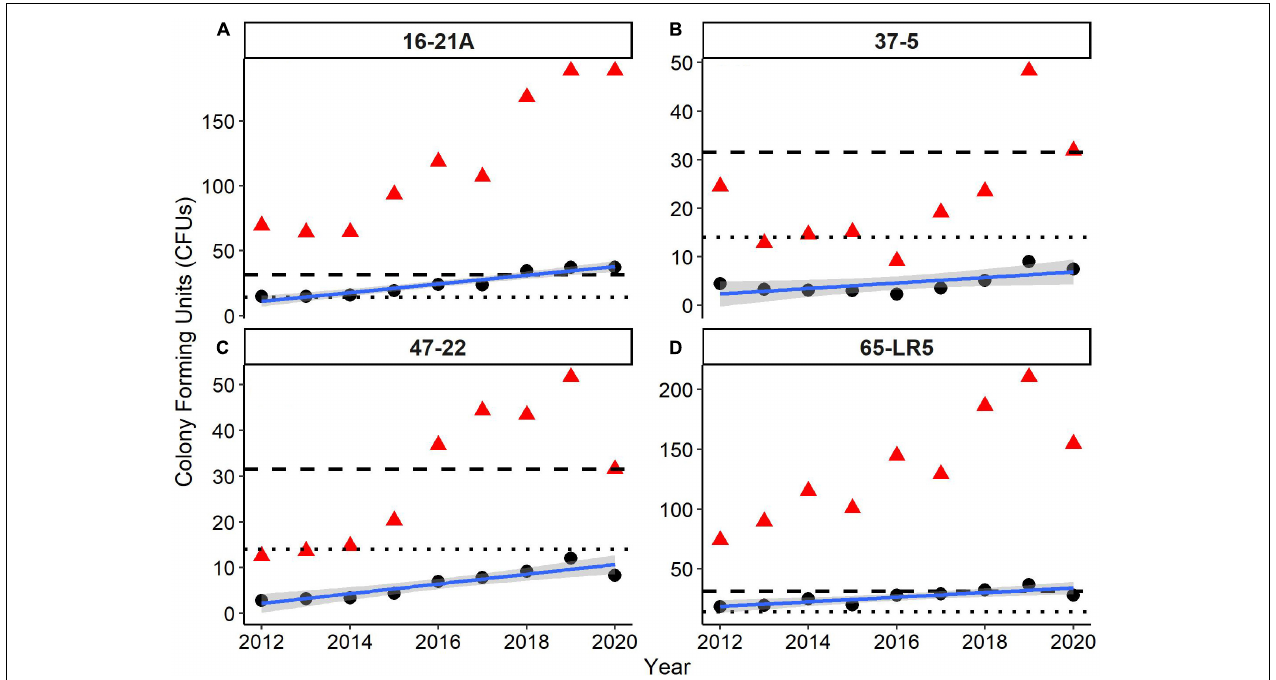
FIGURE 2 | The number of Escherichia coli colony forming units (CFUs) for four water quality monitoring sites spread throughout the Chesapeake Bay from 2012 to 2020. The annual geometric mean (black circle) and its trend line (solid blue line) along with the estimated 90th percentile (red triangle) are provided with horizontal lines representing the closure thresholds for an annual geometric mean (dotted; 14 CFUs) and the 90th percentile (dashed; 31.5 CFUs). Station names are provided above each plot. Each of the displayed stations had significant ( α = 0.05) positive trends and were closed in 2020. Panels (A) and (D) exceeded both thresholds, while panels (B) and (C) only exceeded the 90th